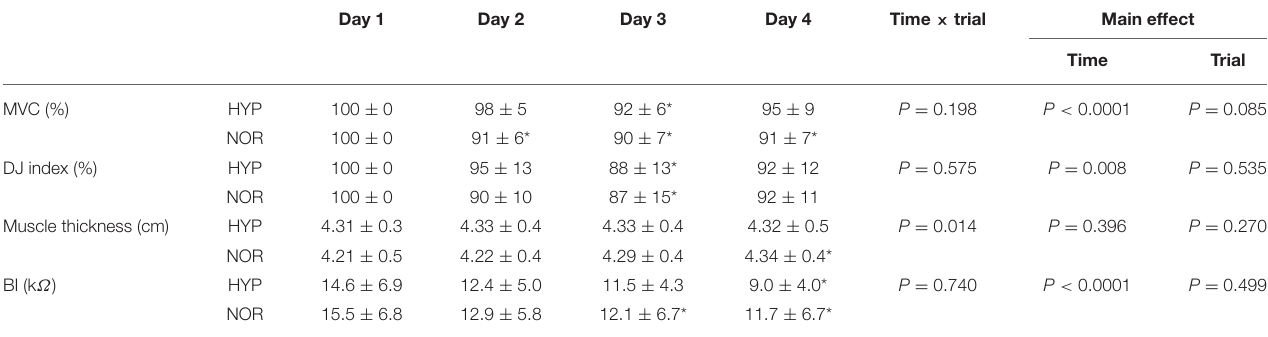
TABLE 3 | Changes in MVC, DJ index, and muscle swelling variables of lower